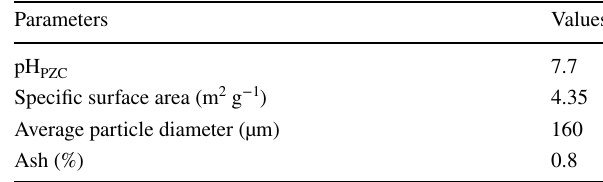
Table 1 Physicochemical characteristics of chitin